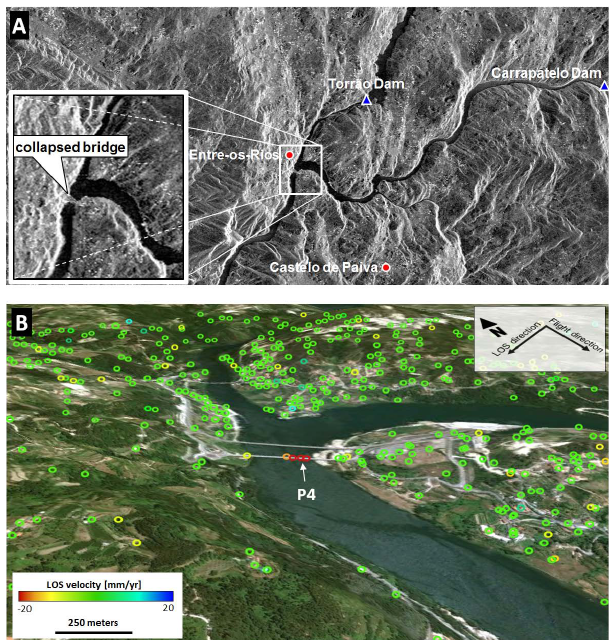
Fig. 6. (A) Mean SAR amplitude image of the study area with the region of the bridge extended and the location of the dams whose water volumes discharged were used to infer the flow in the area of the bridge; (B) geocoded color coded average linear deformation rate superimposed over a Google Earth image with the collapsed pil- lar highlighted (P4). Observation geometry is indicated in the upper right corner. Figure generated by viStaMPS (Sousa et al., 2013).